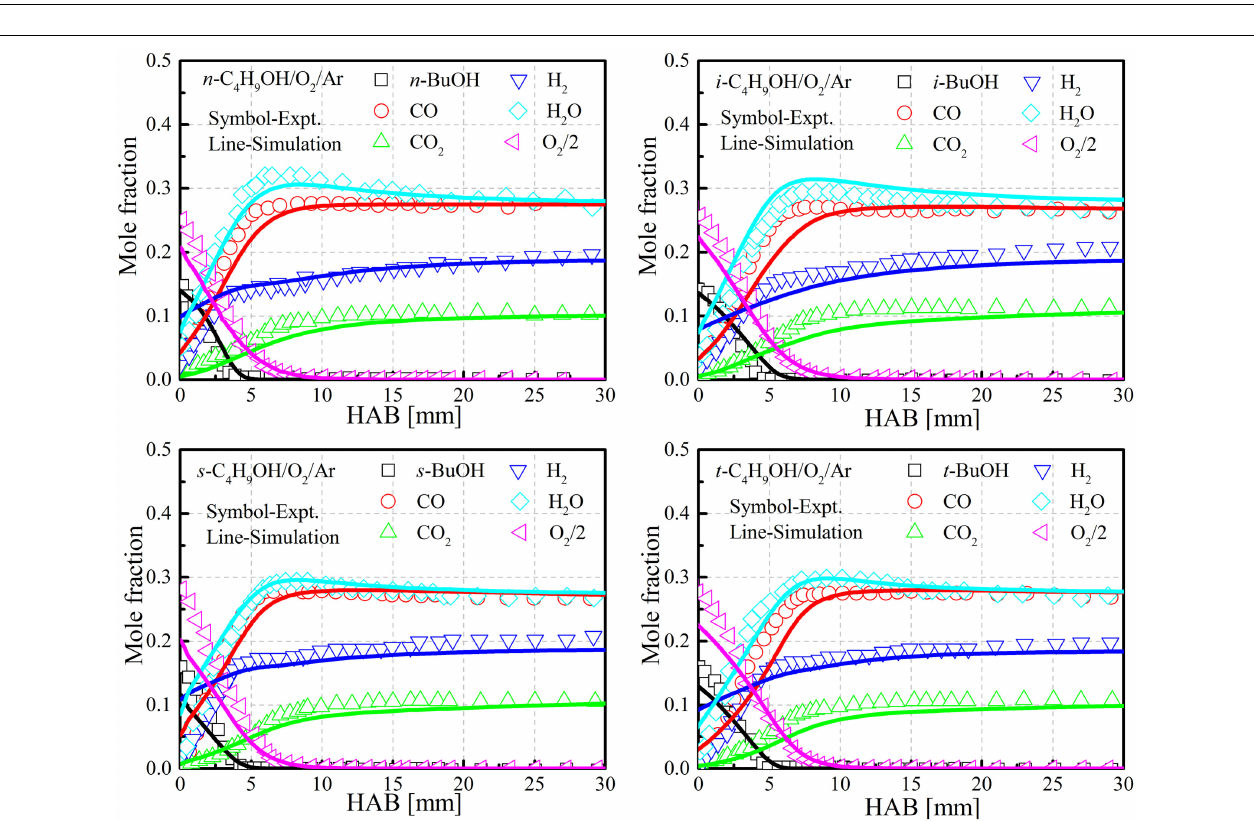
FIGURE 6 | Comparison of species profiles for the four butanol isomers between experiments and simulations . Experimental data taken from Oßwald et al. (2011).